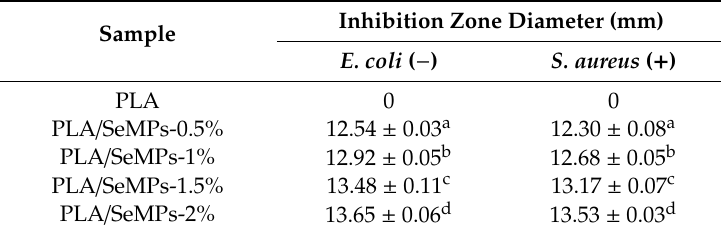
Table 5. E ff ect of PLA and the PLA / SeMPs composite membrane on the growth inhibition rate (%) of E. coli and S. aureus cultured at 37 ◦ C for 24